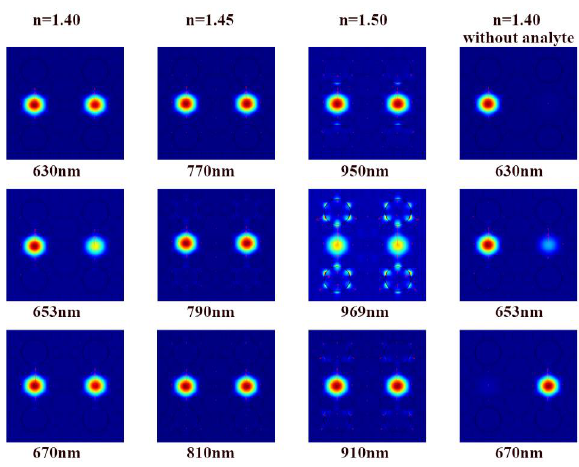
Figure 4. Fundamental mode profiles for different analyte RIs (the second line of the profiles is at the phase matching point or at the avoided crossing point except for the fourth profile. The two large holes near the center have no analyte in the fourth column.).